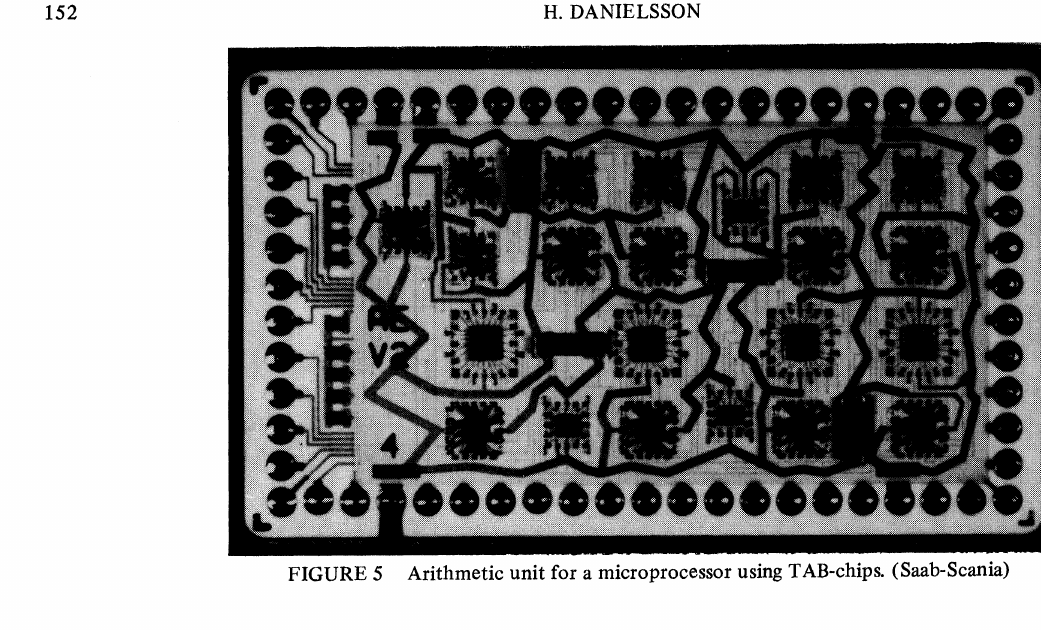
FIGURE 5 Arithmetic unit for a microprocessor using TAB-chips.